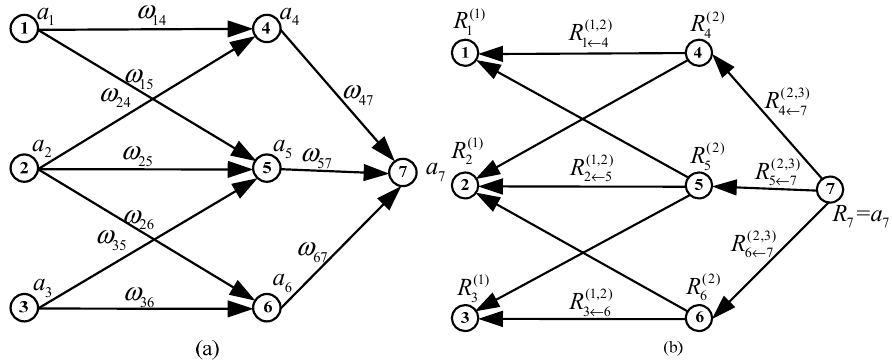
Figure 2. LRP propagation process. ( a ) Forward propagation of neural networks. ( b ) Calculating LRP in backward direction.